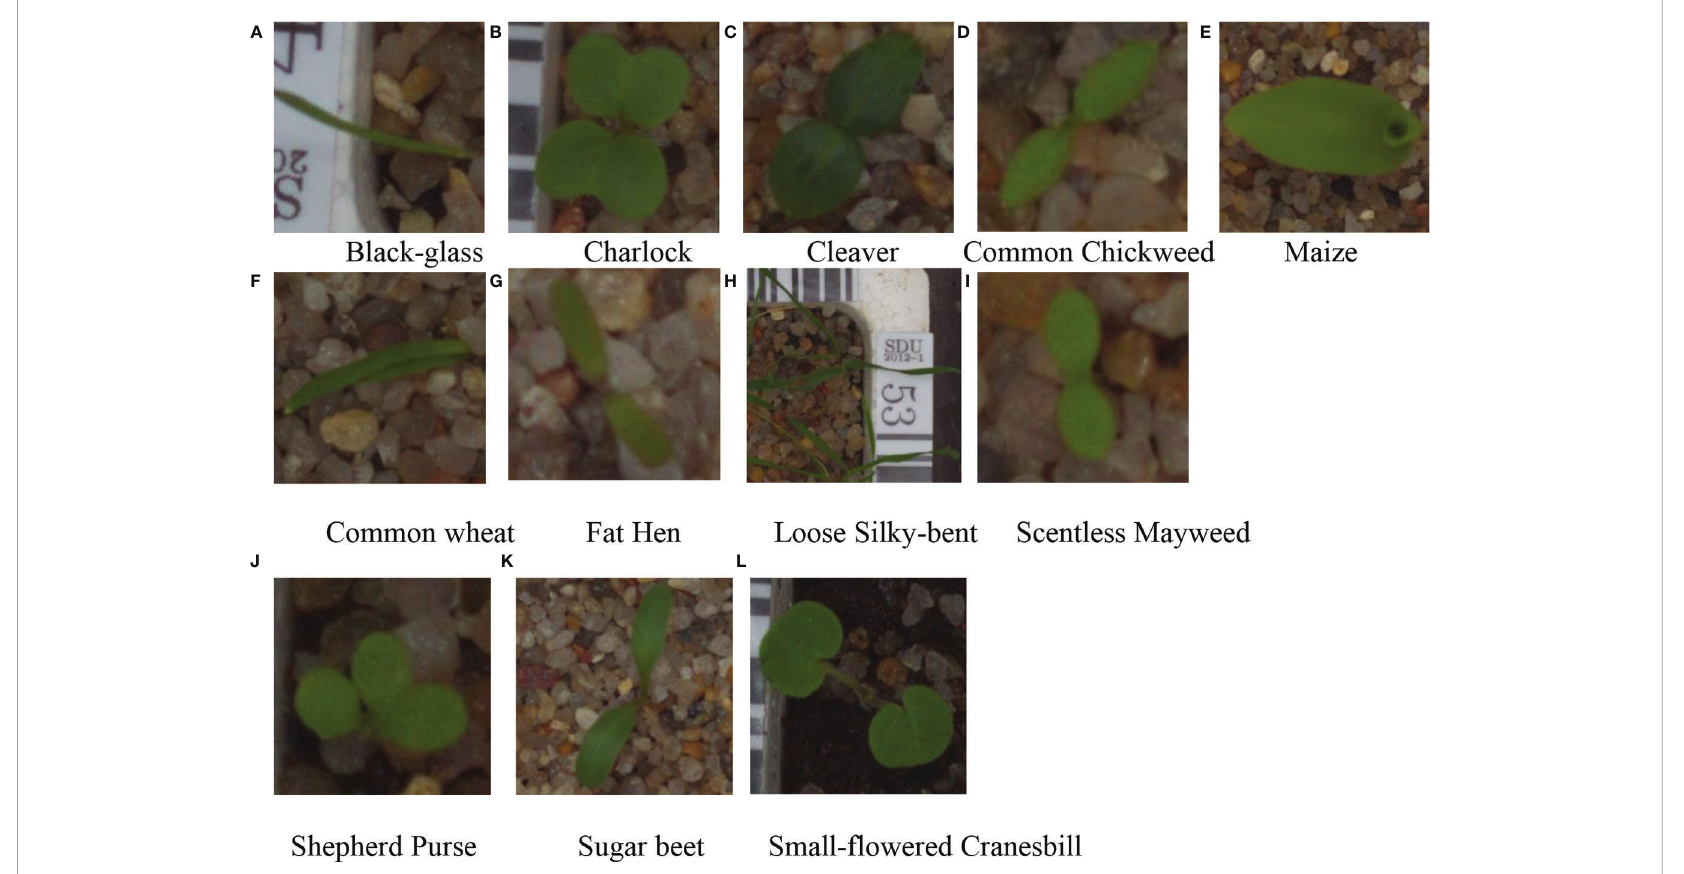
FIGURE 2 Partial dataset. (A) Black-glass (B) Charlock (C) Cleaver (D) Common Chickweed (E) Maize (F) Common wheat (G) Fat Hen (H) Loose Silky-bent (I) Scentless Mayweed (J) Shepherd Purse (K) Sugar beet (L) Small- fl owered